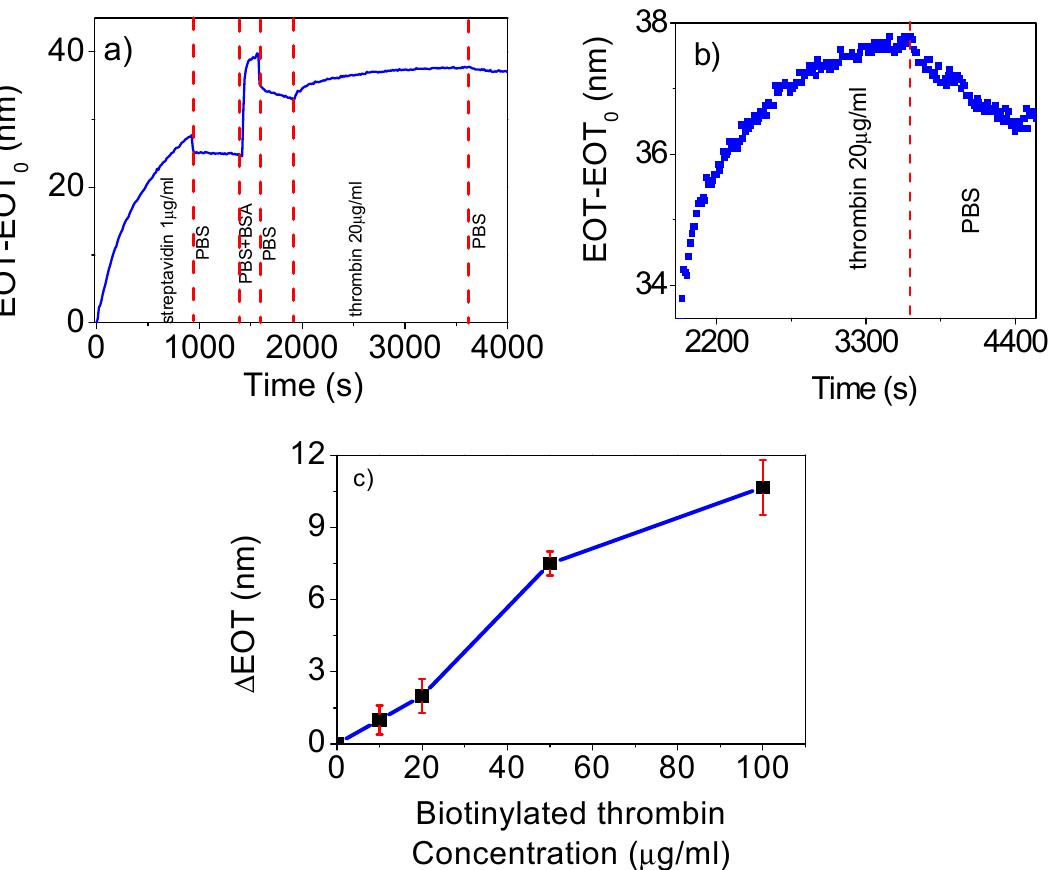
Figure 6. ( a ) Example of EOT variation with time for a biotinylated thrombin attachment experiment intended to evaluate the sensitivity of the NAA platform, corresponding to the concentrations specified on the graph. ( b ) A close-up of the EOT variation with time for one of the experiments conducted at a biotinylated thrombin concentration of 20 µ g/mL. ( c ) Total change of EOT in the biotinylated thrombin attachment step (EOT) against biotinylated thrombin concentration.